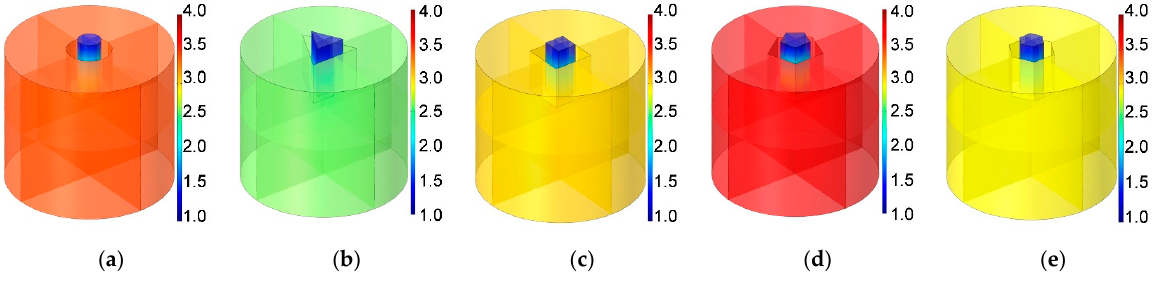
Figure 25. Distribution of acoustic pressure for the HR with the aperture for various cross-sectional shapes. ( a ) Round; ( b ) regular triangle; ( c ) square; ( d ) regular pentagon; and ( e ) regular hexagon.